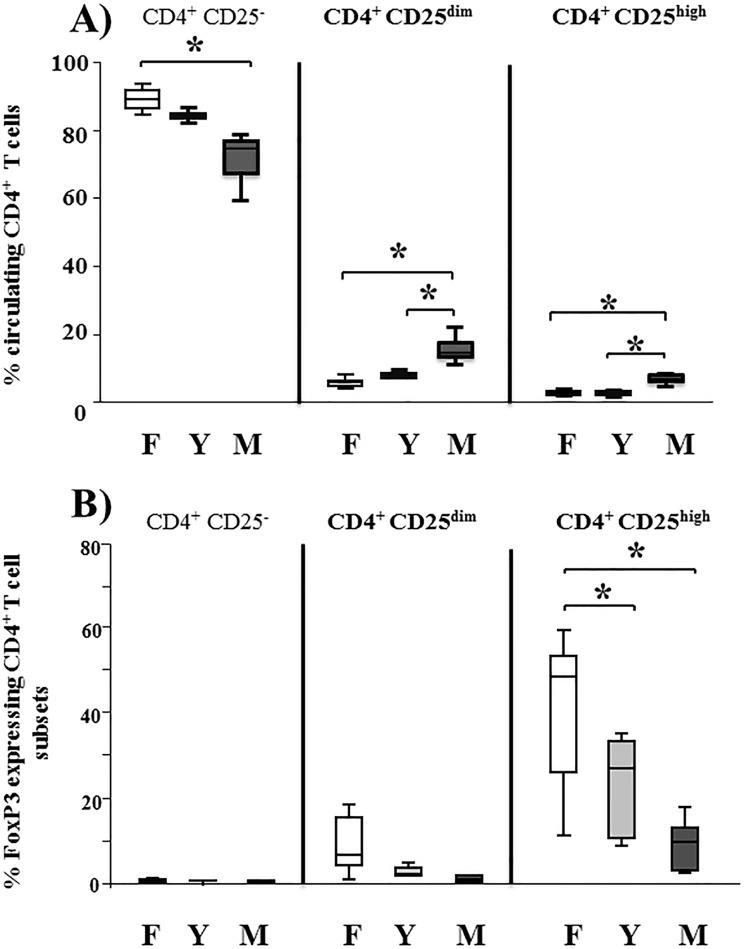
Proportion of circulating CD4+ T cell subpopulations and expression of FoxP3 in freshly isolated PBMC.4x106 freshly isolated peripheral blood mononuclear cells (PBMC) from foals (F, n = 14, age 1–5 months), yearlings (Y, n = 6) and mares (M, n = 14, age 12–26 years) were stained for CD4, CD25 and FoxP3. The proportion of CD4
+
CD25
−, CD4
+
CD25
dim and CD4
+
CD25
high T cells (A) and expression of FoxP3 (B) within these 3 subpopulations were determined using flow cytometry. While differences between foals and yearlings do not surmount to more than a trend, it became obvious that there is a significant shift in T cell populations between foals and adult animals across all subpopulations. While mares have around twice the amount of CD4+CD25high cells in the blood, foals have around twice the amount of FoxP3+ cells, indicating a shift from nTreg towards activated T cells within this compartment. Results from all horses examined are presented as box plots, whereby, the centre horizontal line of the box plot marks the median of the sample. The edges of the box mark the first and third quartiles and the whiskers define the upper adjacent value which is the largest observation that is less than or equal to the 75th percentile plus 1.5 times the interquartile range (IQR) and the lower adjacent value which is the smallest observation that is greater than or equal to the 25th percentile minus 1.5 times IQR. Comparisons were performed using Kruskal-Wallis Multiple-Comparison Z value Test with Bonferroni correction. The asterisk indicates statistical significance differences of p ≤ 0.05.